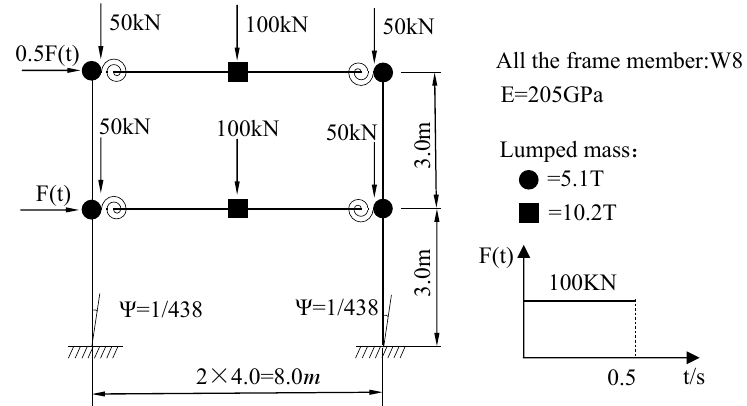
Figure 10. The configuration and loading of the structure adopted in dynamic analysis.